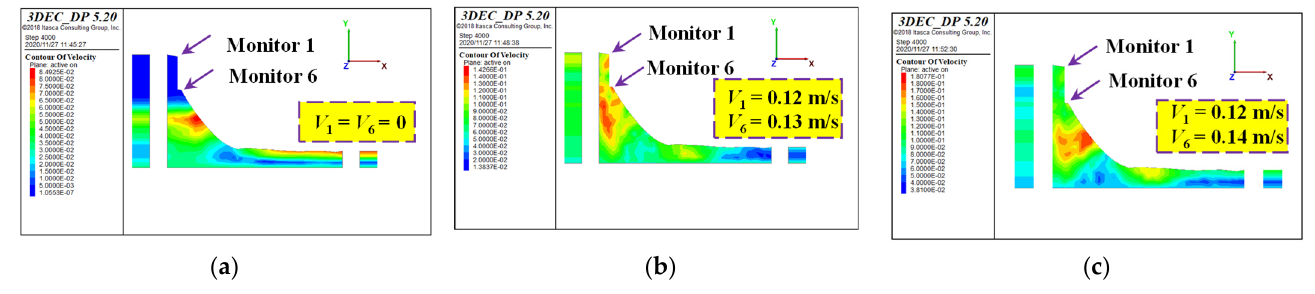
Figure 12. Dynamic response of the high-steep rock slide (4000 steps). ( a ) EW seismic wave; ( b ) UD seismic wave; and ( c ) EW_NS_UD seismic wave.